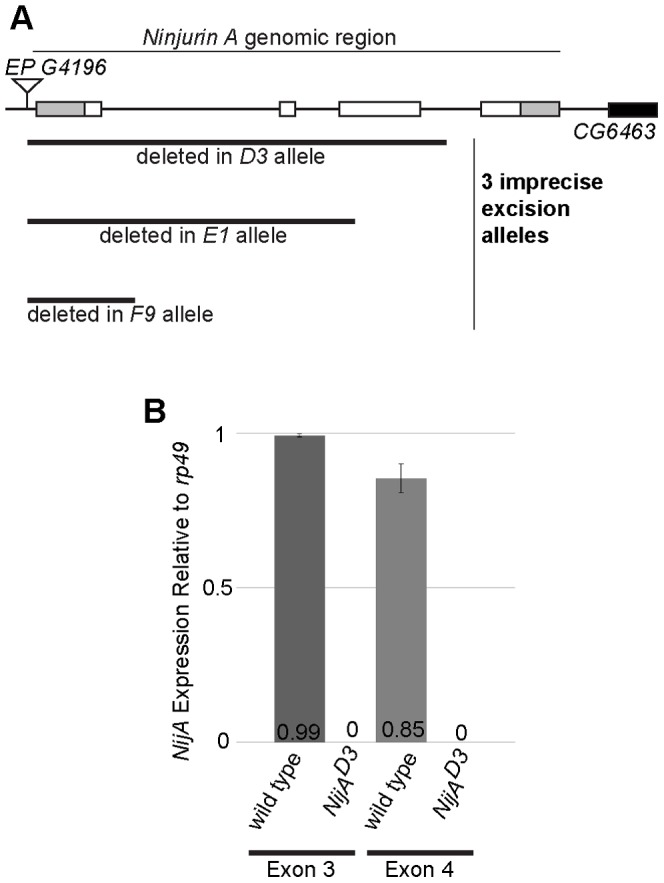

NijAD3 mutants do not express mRNA from the NijA genomic locus.(A) Schematic of the NijA locus showing all four exons. Gray indicates untranslated regions and white indicates open reading frame. Three excision alleles (D3, E1, and F9) were generated from imprecise excisions of EP G4196. (B) qPCR data from primers specific to exon 3 (a negative control, as it is deleted in the D3 allele) or exon 4 of NijA. The NijAD3 mutant did not produce any detectable mRNA from exon 4 of the NijA locus, even though exon 4 remains in the genome, indicating that the D3 allele is a null. Error bars represent standard error of the mean.